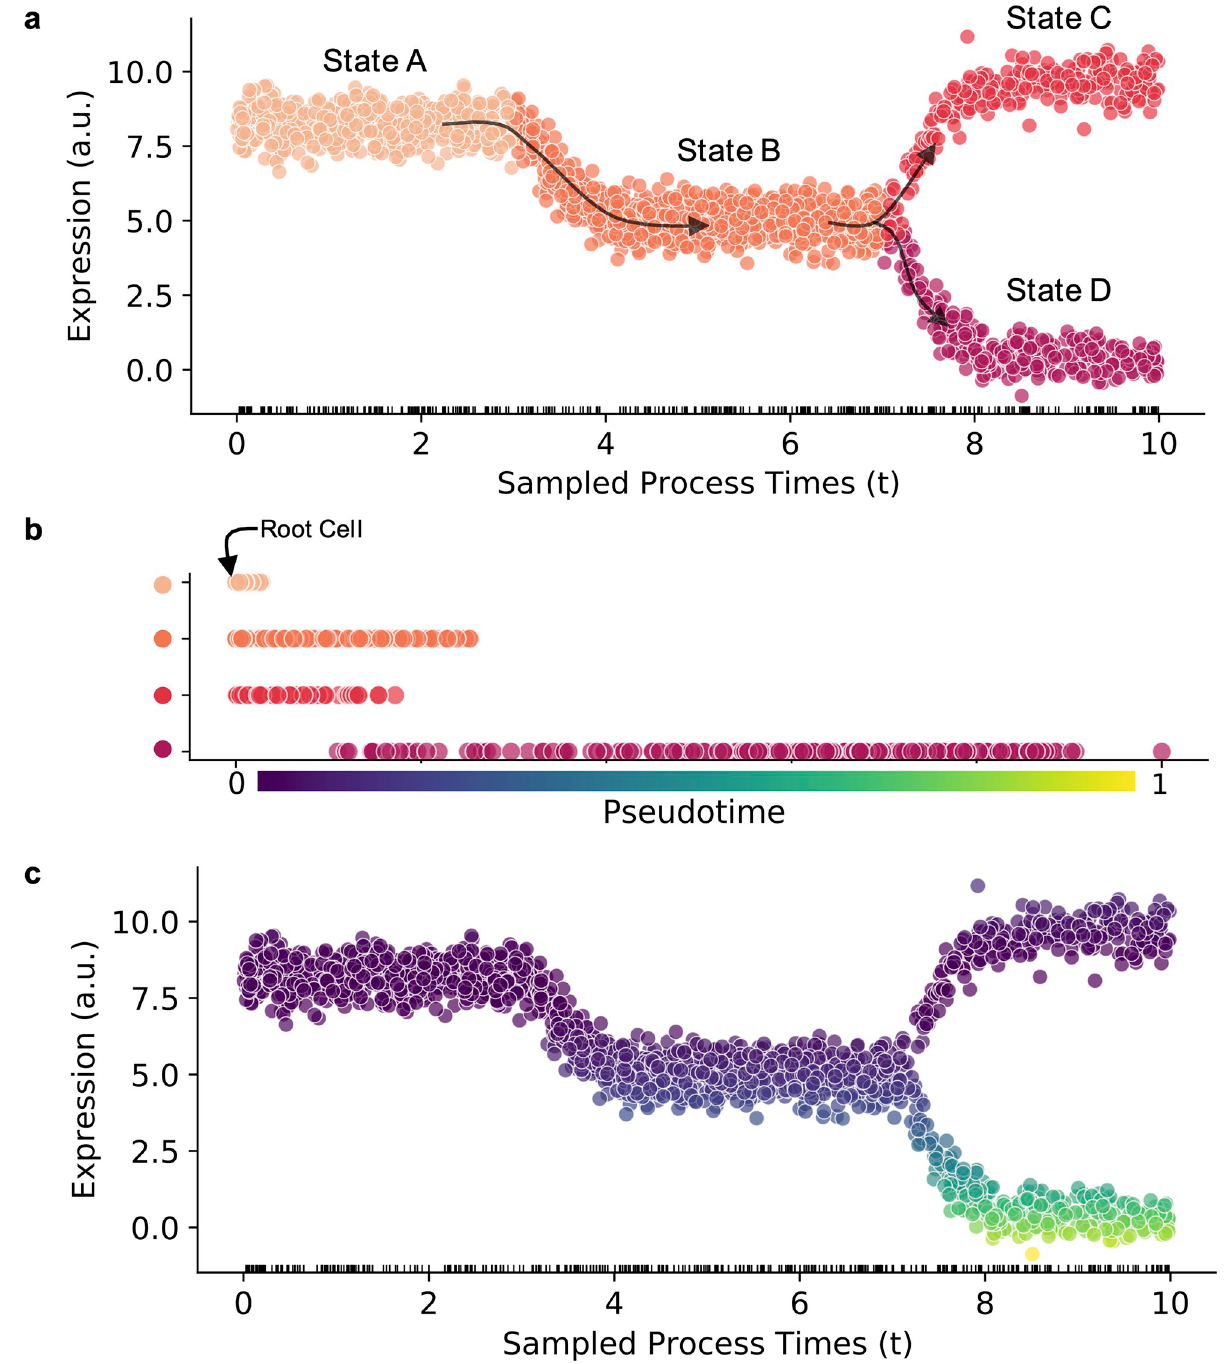
Fig 8. Markov Chain process time versus expression pseudotime. a. Simulated gene expression for 2000 cells over 4 states (states A, B, C, and D) with a bifurcation at C/D showing spliced counts of a single gene at the sampled process times. The abbreviation a.u. denotes arbitrary units. b. Ordering of all cells by expression pseudotime coordinate, calculated as the Euclidean distance between each cell and the root cell (cell at time t = 0) and scaled to between 0 and 1. c. The sampled cells colored by the calculated pseudotime value.